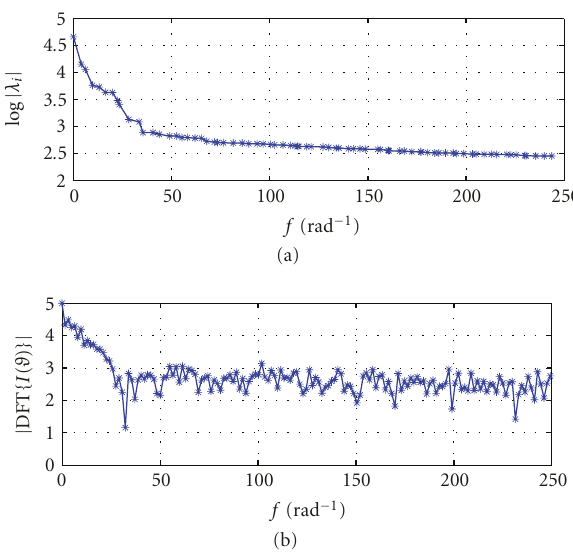
Figure 5: Three nm Au synthetic sample with NSR = 10%: (a) noiseless synthetic XRD intensity profile as a function of the scatter- ing angle ϑ ; (b) di ff erence between noiseless and filtered (see middle plot of Figure 3)